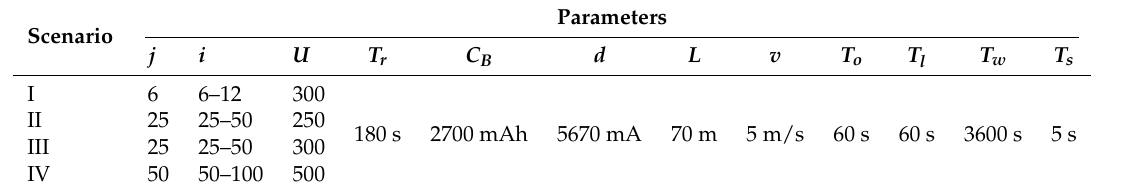
Table 2. Simulation